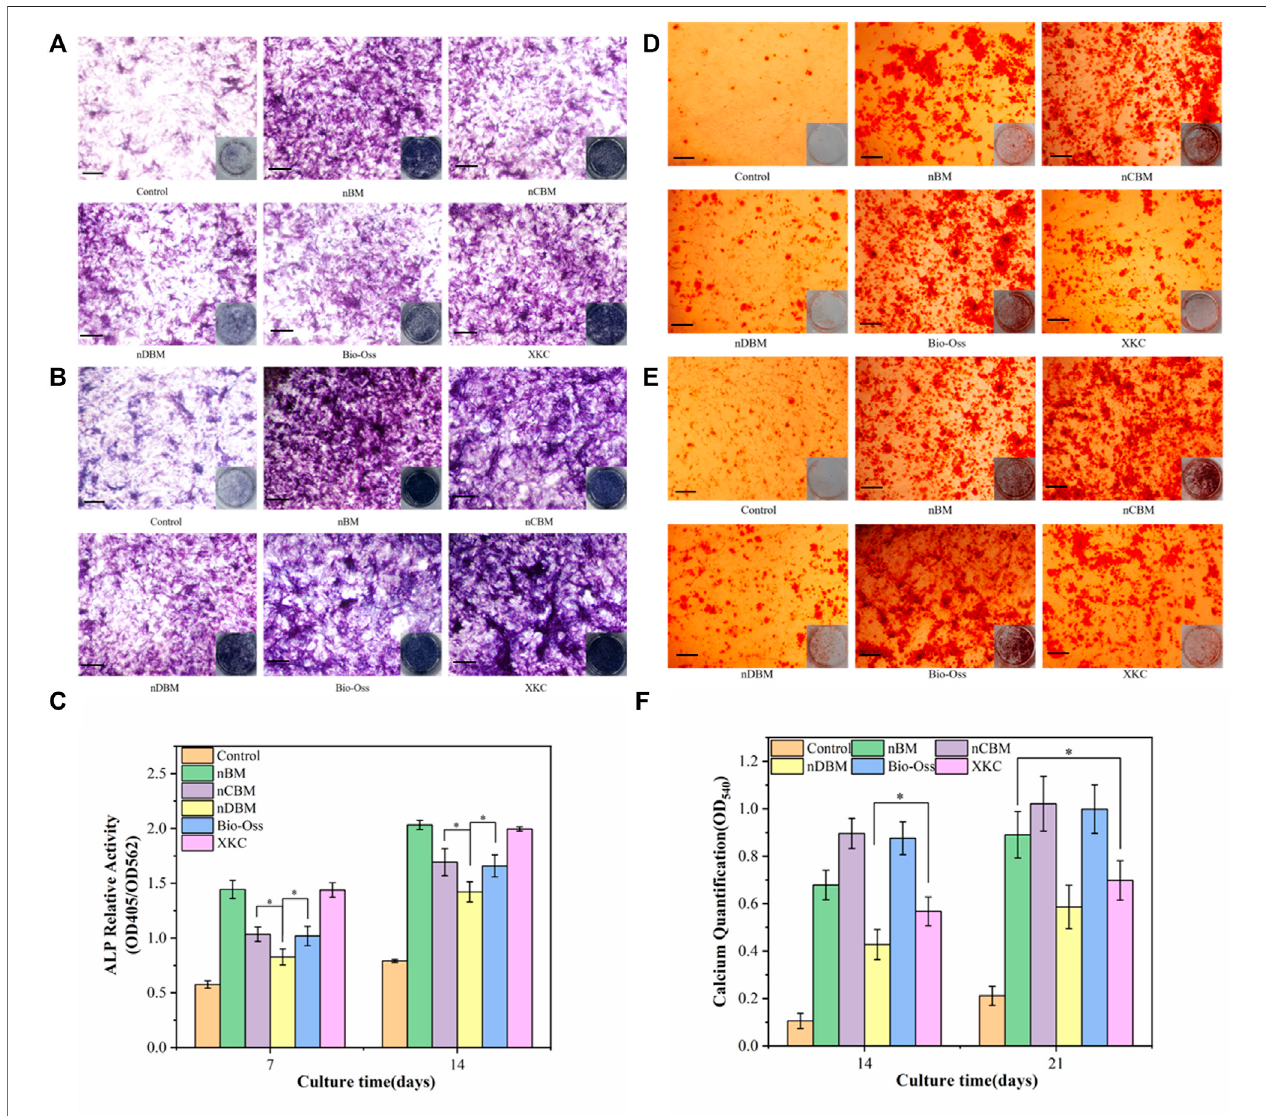
FIGURE 11 | Alkaline phosphatase (ALP) staining (A,B) and alizarin red staining (D,E) in BMSCs cultured on different bone powders for 7 and 14 days (ALP) and 14 and 21 days (AR). (C) Corresponding quantitative evaluation of relative ALP activity in BMSCs cultured on different bone powders for 7 and 14 days. (F) CorrespondingquantitativeevaluationofcalciumcontentandmineraldepositioninBMSCsculturedondifferentbone powdersfor14and21 days.Scalebars:100 μ m. * p < 0.05.